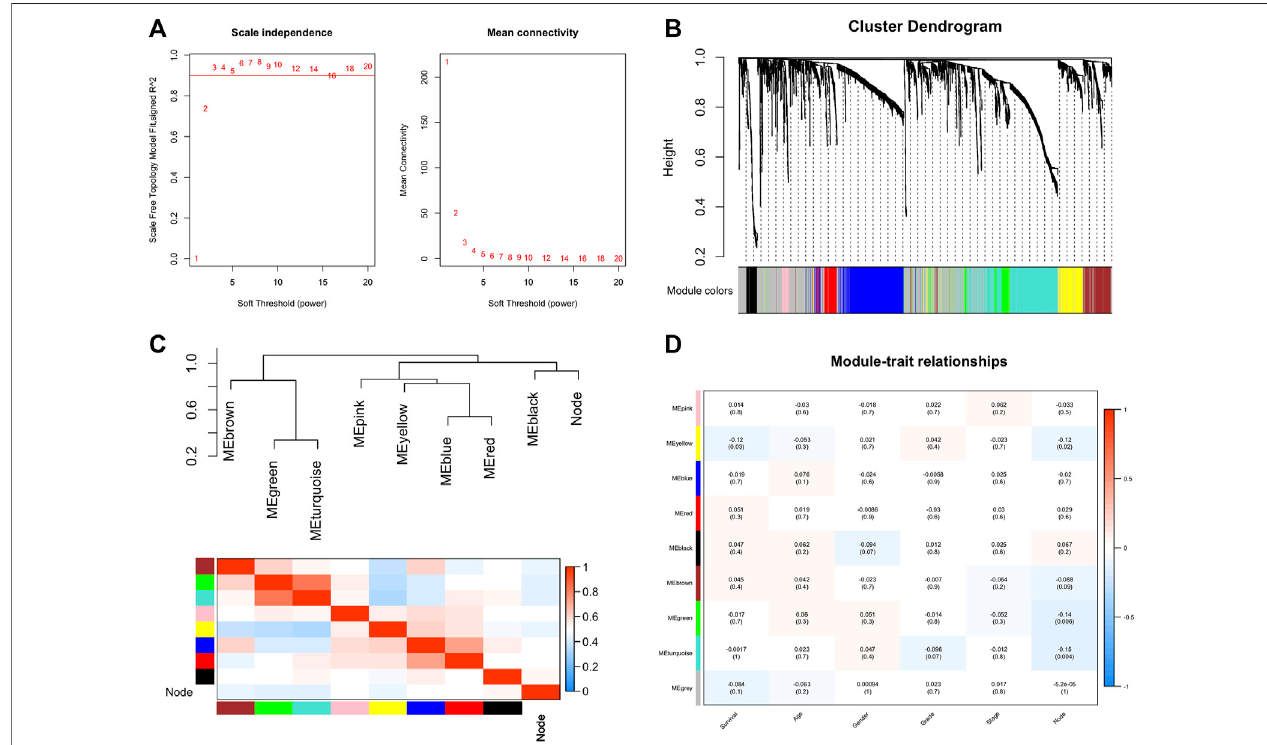
FIGURE 1 | Construction of co-expression network through WGCNA. (A) Network topology for different soft-thresholding powers. (B) A cluster diagram of gene clusterofbladdercancer. (C) Heatmapoftheadjacenciesinthehubgenenetwork. (D) Heatmapofthecorrelationbetweenmoduleeigengenesandtheclinicalfeatures. WGCNA: weighted gene co-expression network